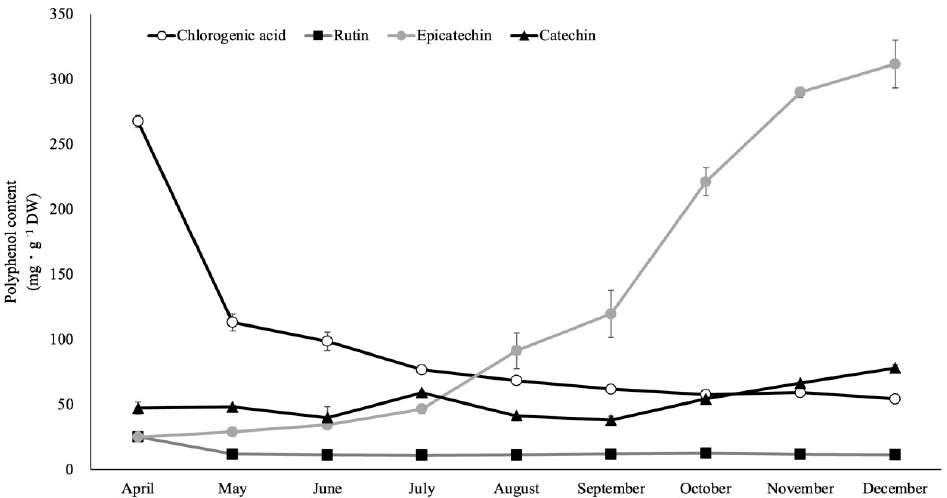
Figure 6. Seasonal changes in content of chlorogenic acid, rutin, catechin, and epicatechin in mature leaves of rabbiteye blueberry ‘Homebell’.